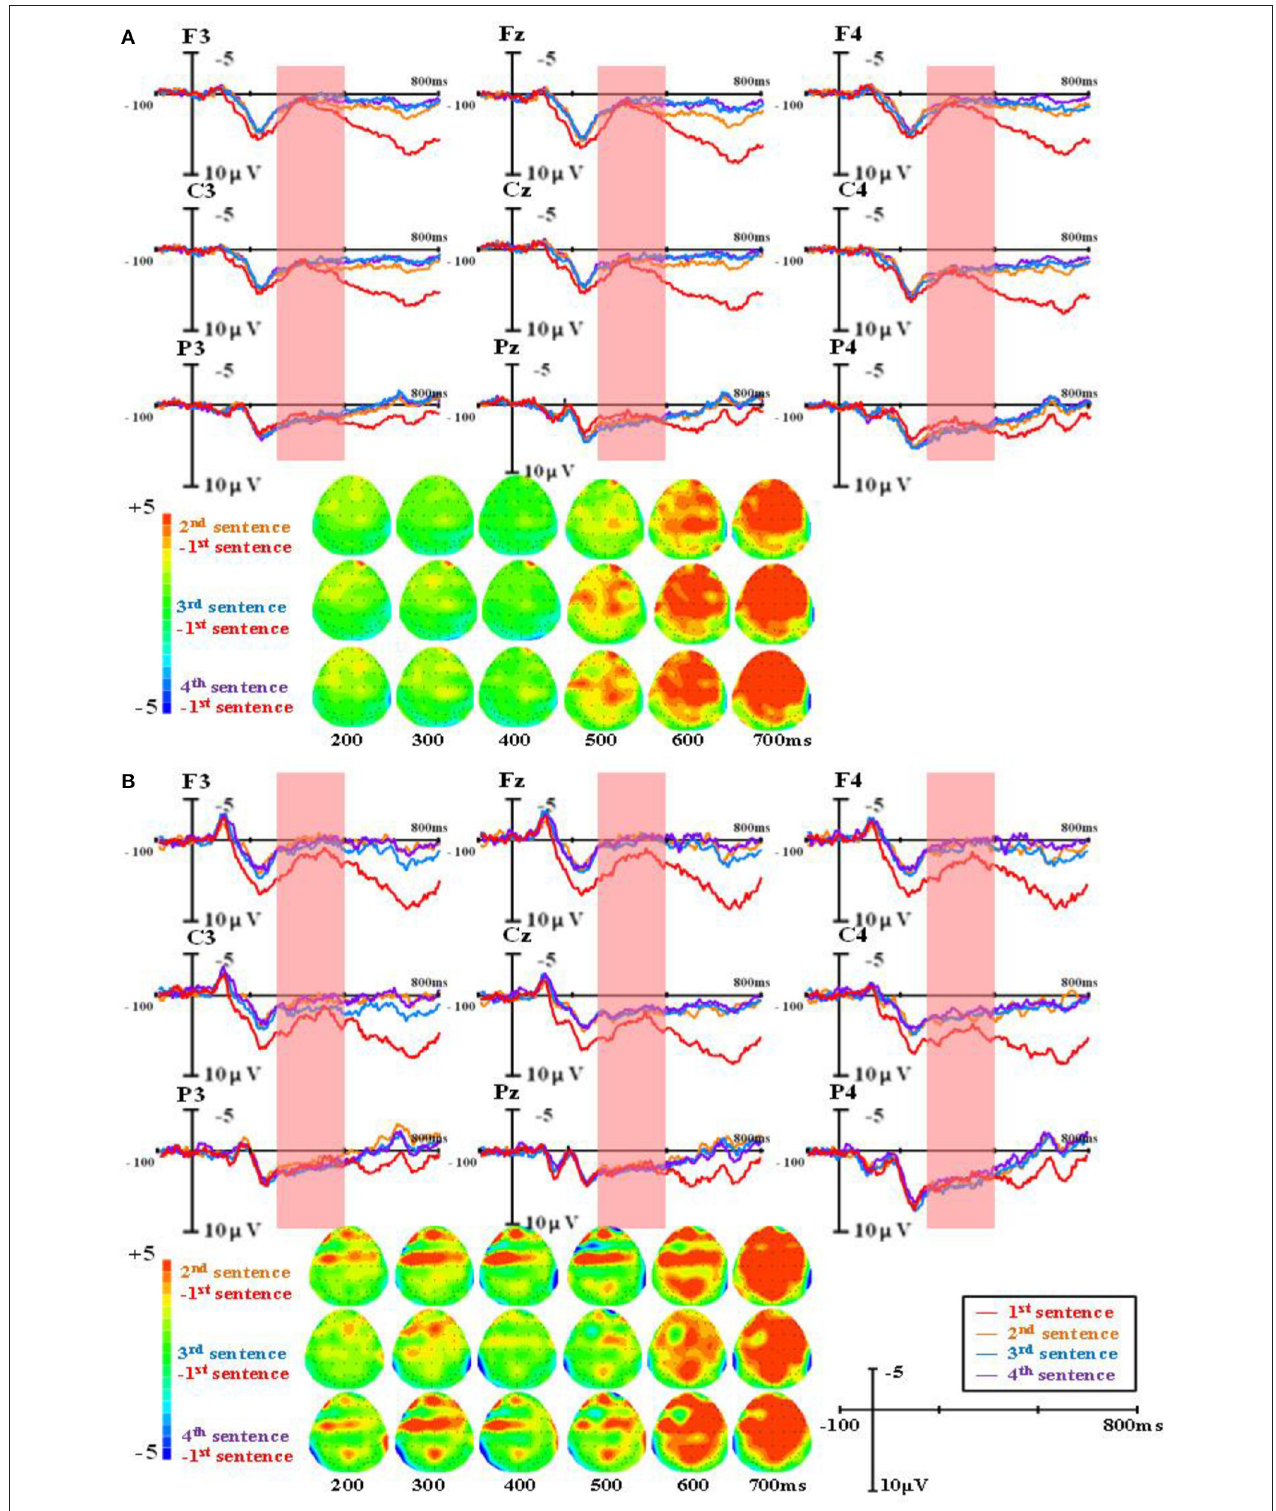
FIGURE 4 | The group-level average waveforms and scalp distribution elicited by pseudowords of different sentences (M- condition) for higher proficiency (A) and lower proficiency participants (B) .